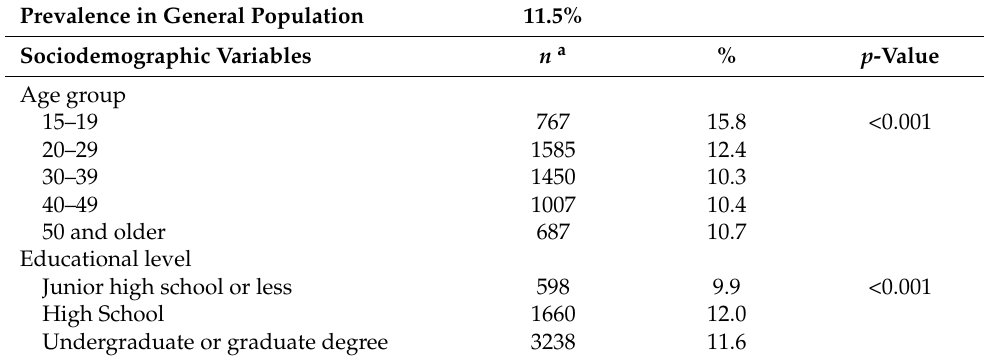
Table 2. Prevalence of Domestic Violence Against Women in the Past Month by Variables of